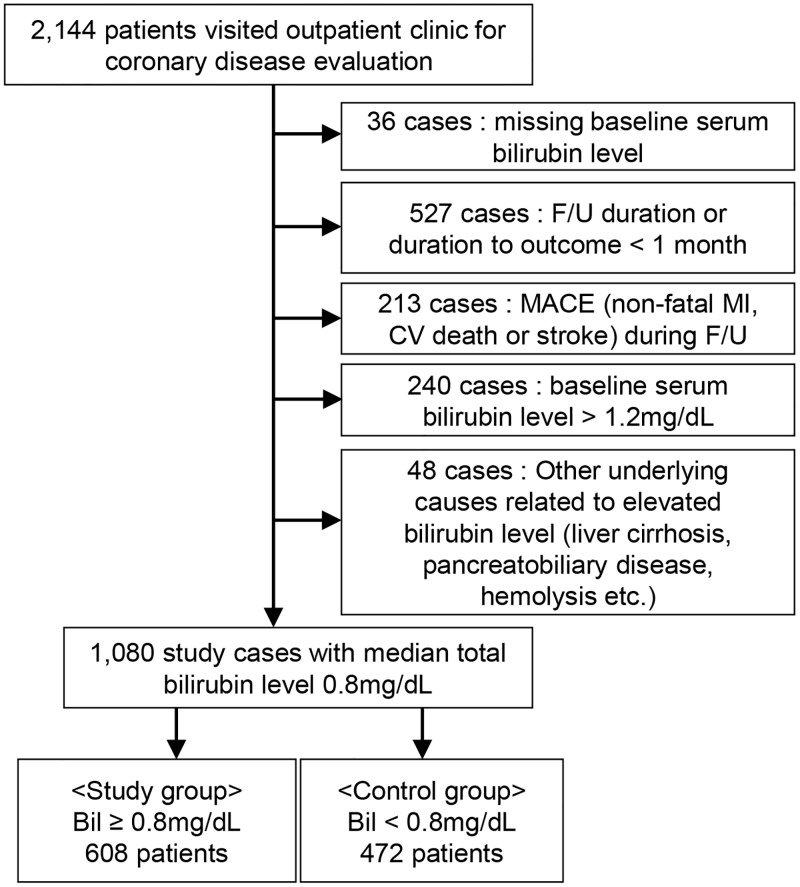
Flow diagram of the selected study population.